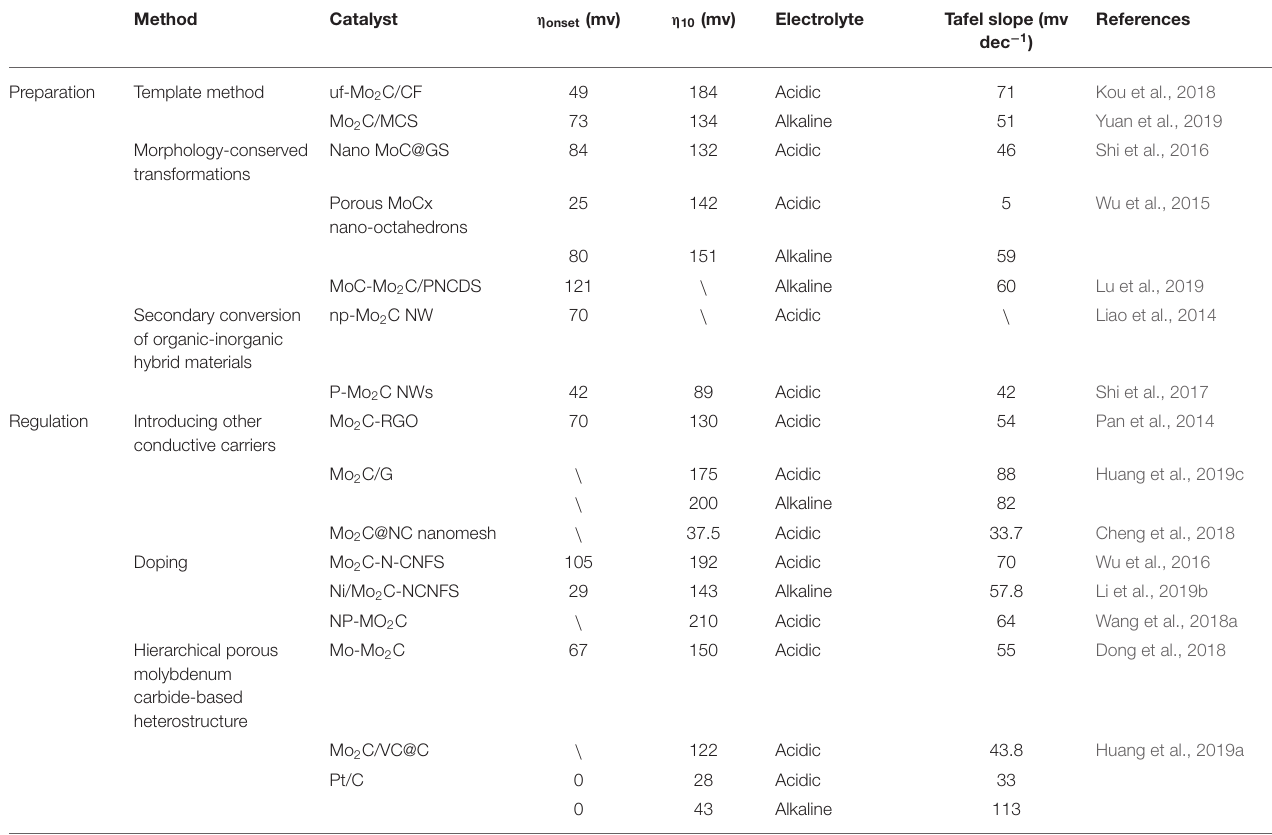
η 10 , overpotentials to drive the current densities of 10 mA cm − 2 . η onset , oneset